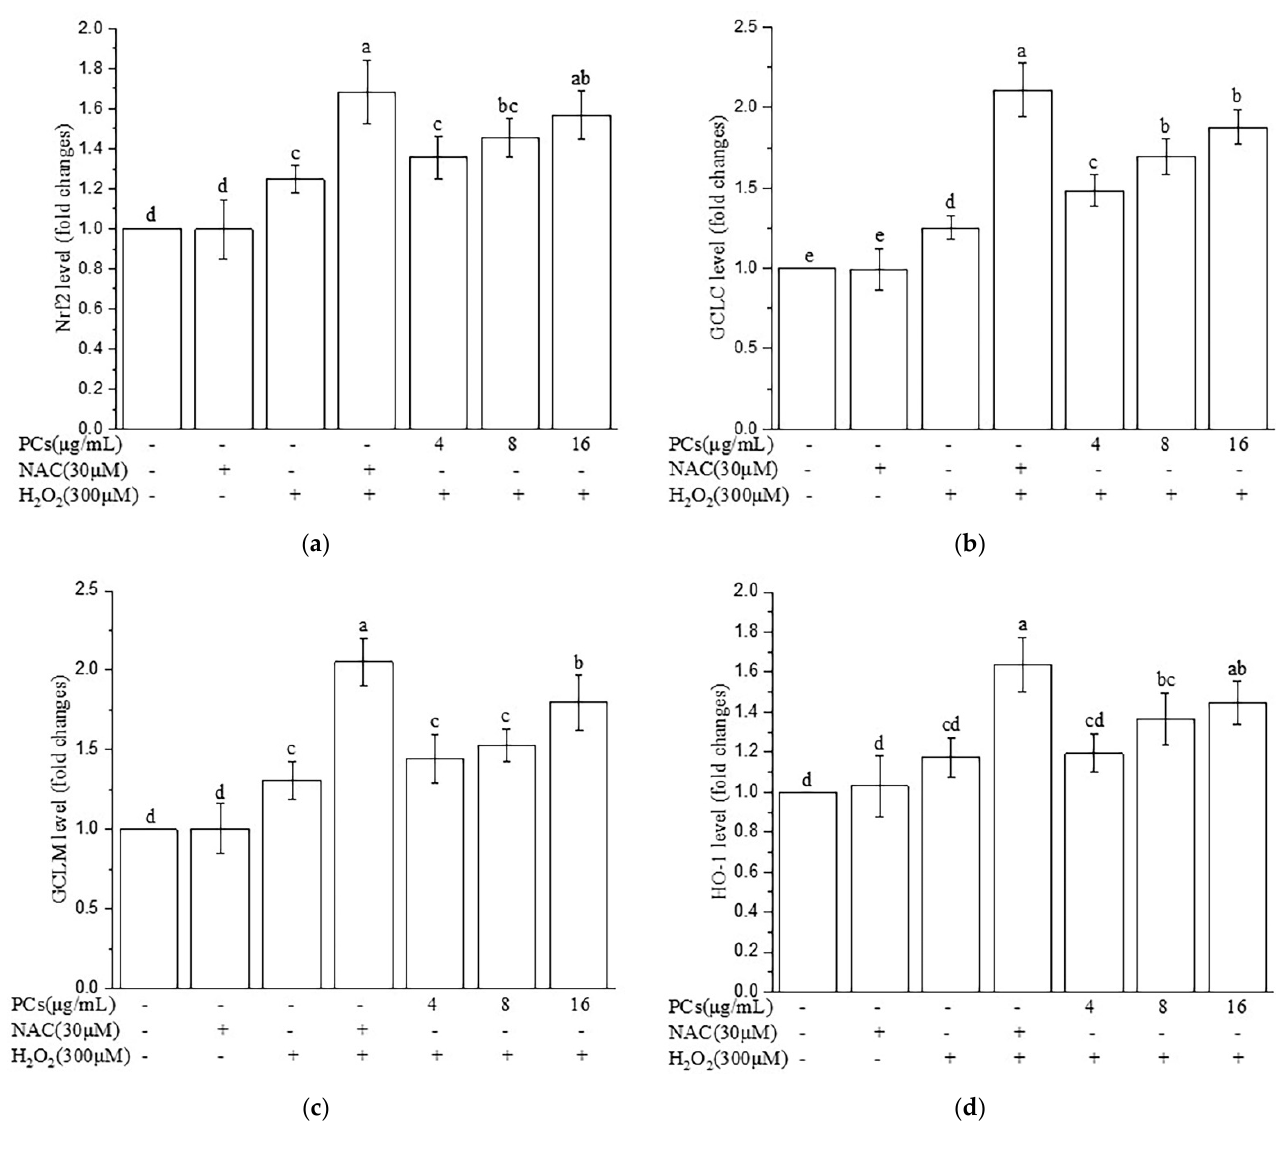
Figure 6. Effects of PCs on oxidative stress in H 2 O 2 -treated zebrafish larvae. ( a ) Representative fluorescence photomicro- graphs of zebrafish larvae; ( b ) ROS levels were measured via imaging software; ( c ) MDA levels; ( d ) GSH-Px activity; ( e ) CAT activity; ( f ) SOD activity. Data are expressed as the mean ± SD. All experiments were conducted three times. Values with different letters above are significantly different ( p < 0.05, one-way ANOVA).